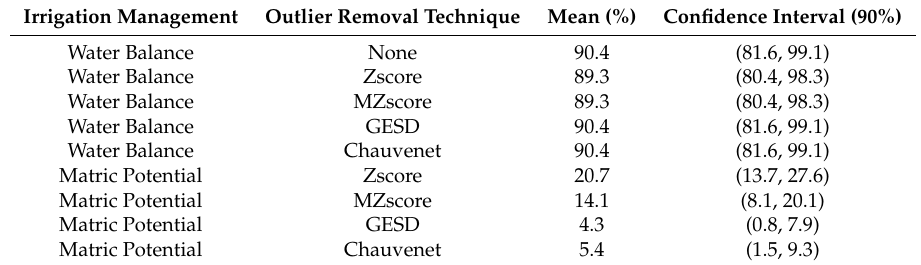
Table 3. Percentage of water saved over six months by irrigation management using real soil moisture